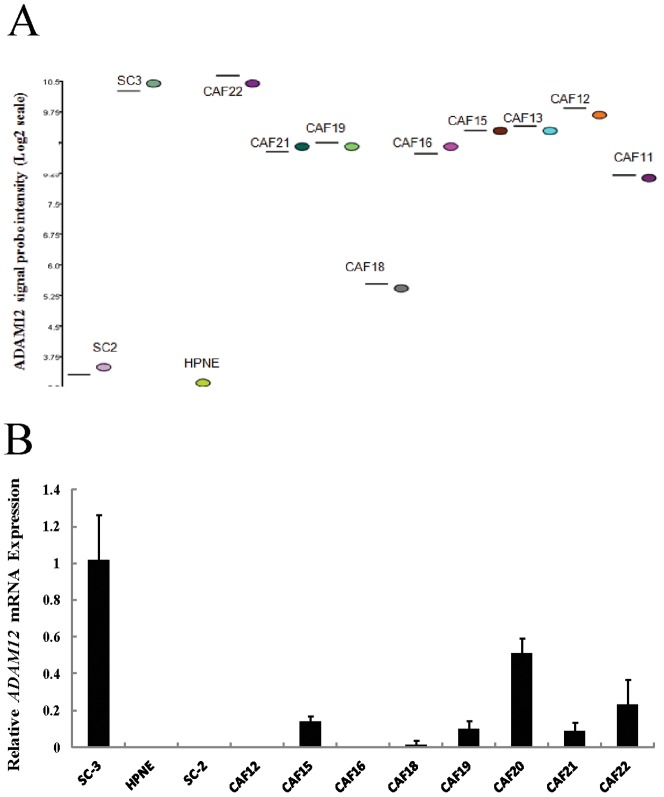
Analysis of ADAM12 mRNA expression in pancreatic CAFs and control fibroblasts.(A) Affymetrix exon array analysis of ADAM12 mRNA expression in pancreatic CAFs and control fibroblasts. (B) Quantitative RT-PCR analysis of ADAM12 mRNA expression in pancreatic CAFs and control fibroblasts after normalization to GAPDH levels. Each assay was performed in triplicate. Data are means of three independent experiments; bars are SD values.